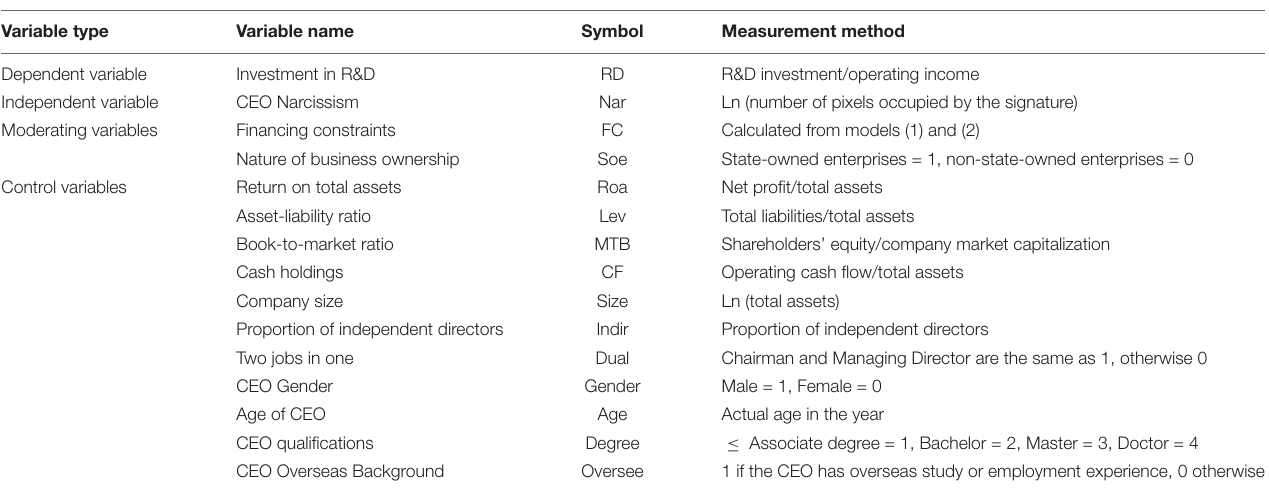
TABLE 1 | Definition and measurement of